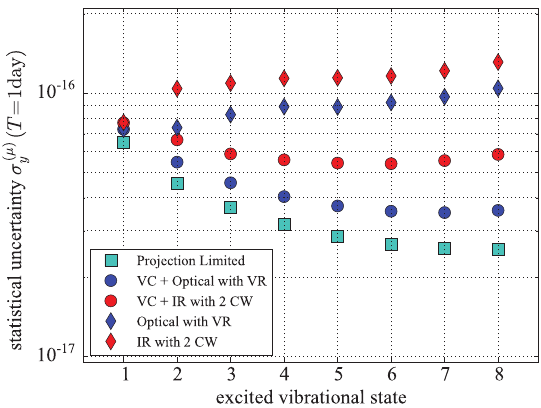
Figure 8. Simulation results for statistical uncertainty using various state preparation schemes, a single TeH + ion and for one day of averaging. Squares represent the projection noise-limited outcome, corresponding to instantaneous state preparation with 100% fidelity. ‘Optical’ indicates results for rotational cooling at 600 nm, with vibrational repump (VR) included. ‘IR’ refers to rotational cooling at 1300 nm, with two CW-assist lasers included. Diamonds indicate results without vibrational cooling, and circles indicate results with each cycle ending with vibrational cooling (VC) followed by rotational